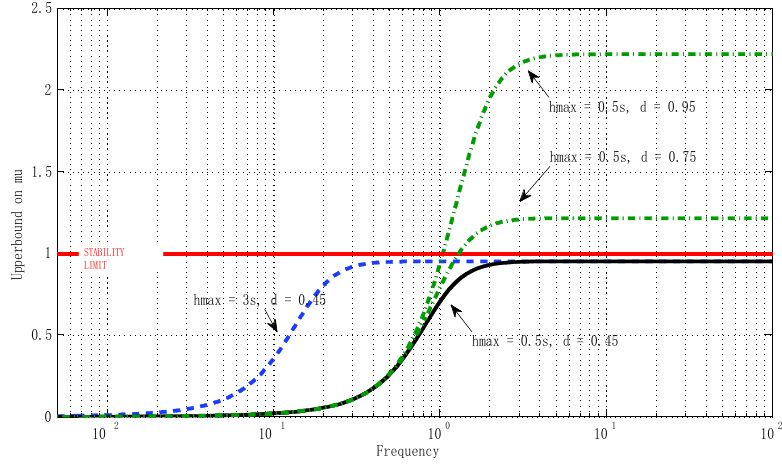
Figure 13. Upper bound on µ for d , h , | η (t)| ď 0.01.